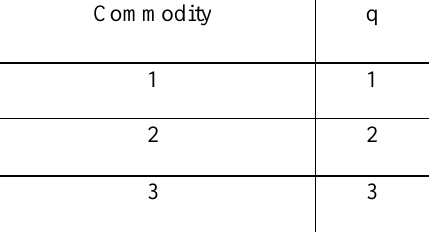
Table 2. Commodity converting